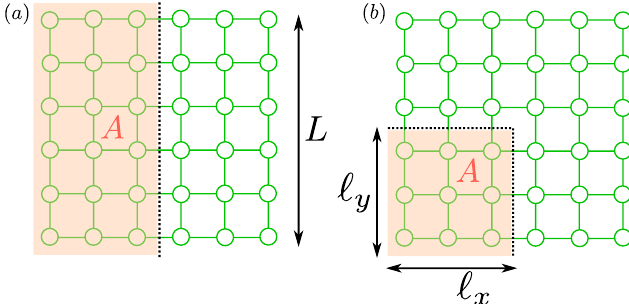
Figure 1: Bipartition of the system as A ∪ ¯ A used in this work. The lattice has L × L sites and periodic boundary conditions in both directions are used. (a) Bipartition with smooth boundary. (b) Bipartition with a corner. We define the aspect ratios ω = (cid:96) / L and ω = (cid:96) / L x x y y